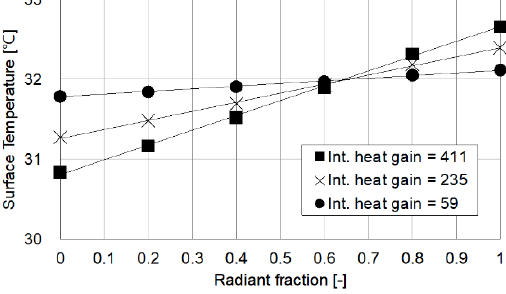
Figure 12. Radiant fraction and surface temperature for internal heat gain.